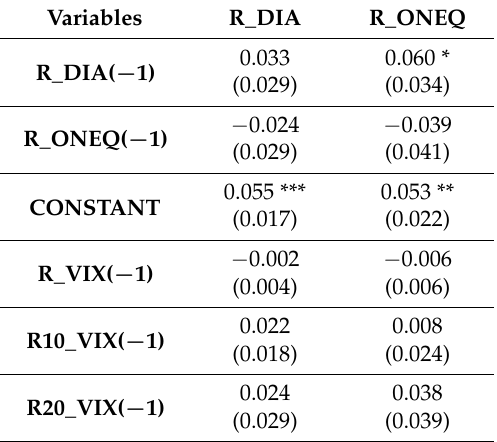
Table 18. Mean Equation for US Market ETF and VIX (Before GFC) (3 October 2003 to 30 October 2007).